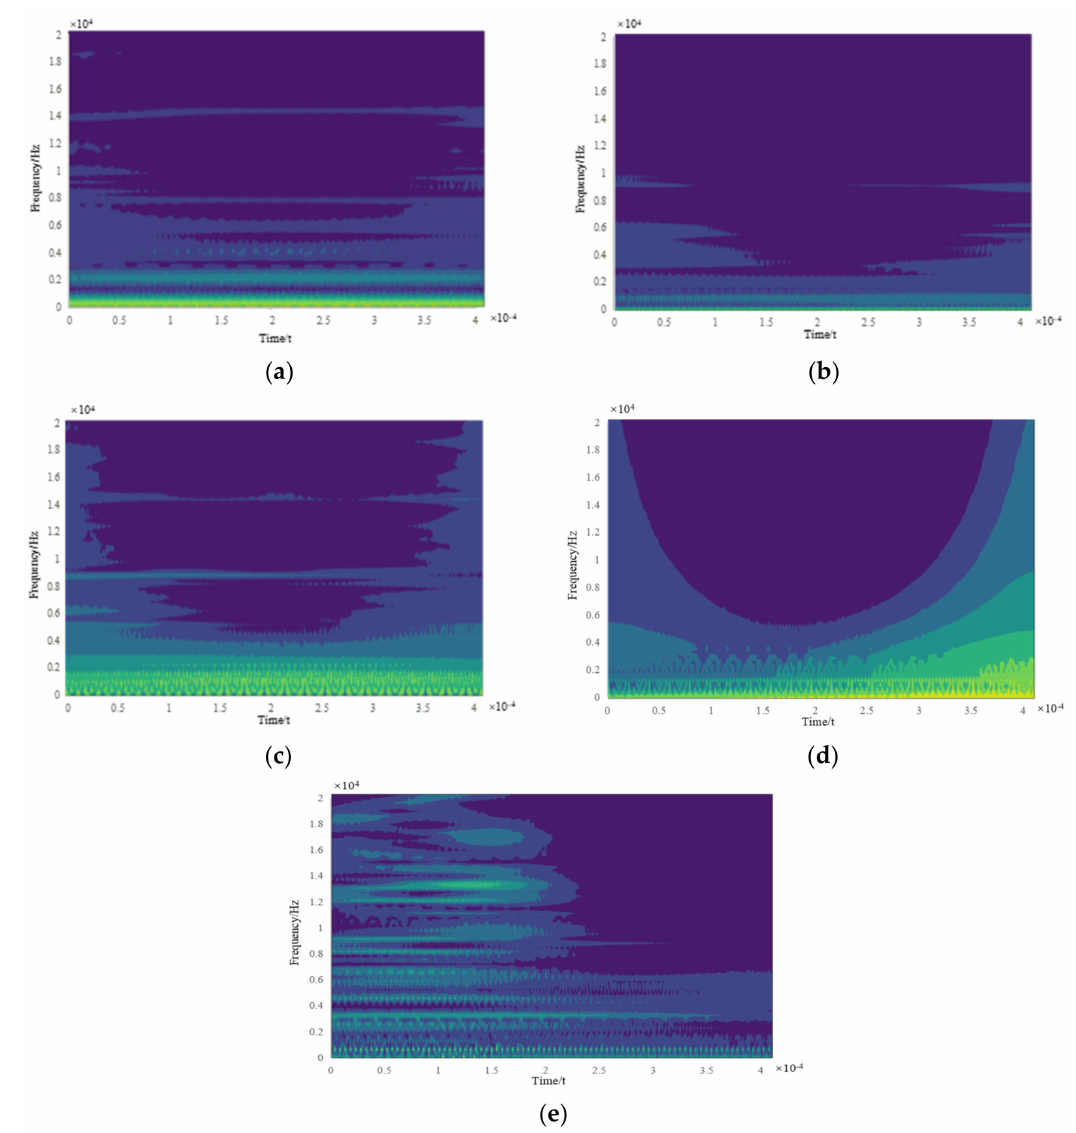
Figure 8. The variance curve of the detail signal D3 obtained by wavelet decomposition of the W-phase electric current signal. ( a ) S1 state wavelet decomposition time-frequency image; ( b ) S2 state wavelet decomposition time-frequency image; ( c ) S3 state wavelet decomposition time-frequency image; ( d ) S4 state wavelet decomposition time-frequency image; ( e ) S5 state wavelet decomposition time-frequency